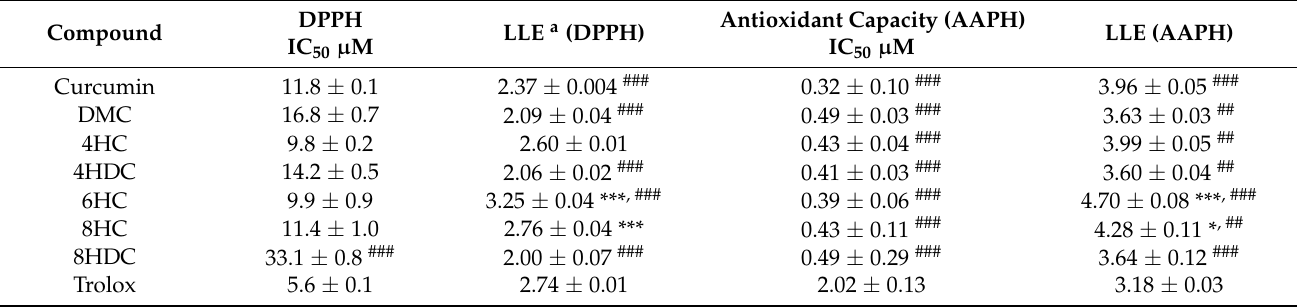
Table 5. Antioxidant activity of hydrocurcumin derivatives. Data represent average ± S.E.M; *: p < 0.05, ***: p < 0.001 by one-way ANOVA and Bonferroni post-hoc test as compared to the corresponding parent compound, i.e., curcumin for 4HC, 6HC and 8HC, and DMC for 4HDC and 8HDC; ## : p < 0.01, ### : p < 0.001 by one-way ANOVA and Bonferroni post-hoc test as compared to trolox, n =